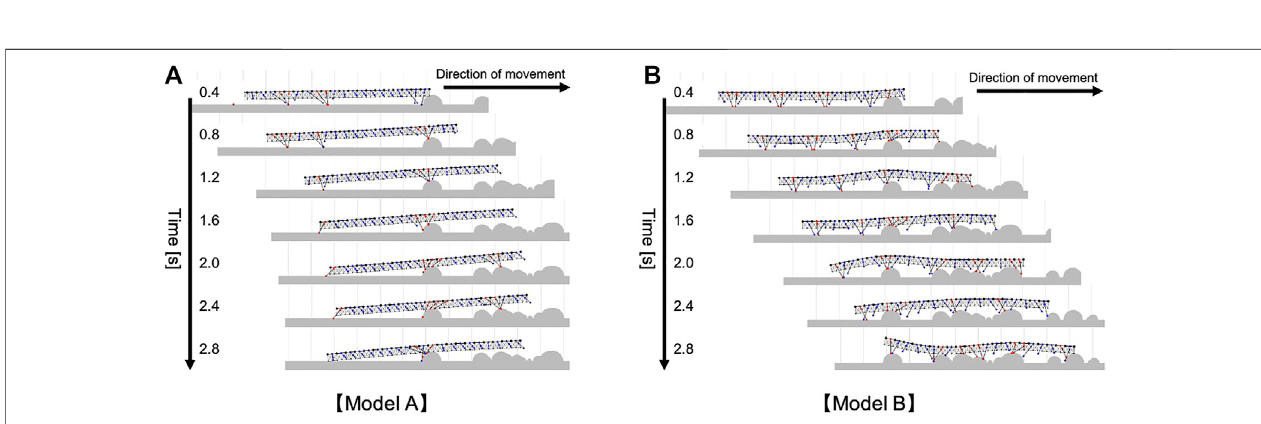
FIGURE8| Snapshotsoftherepresentativesimulatedwalkingonirregularterrainwithmanyobstacles (A) whenModelAwasimplemented, (B) whenModelBwas implemented. These trials were conducted in the same walking environment with Figure 7C .